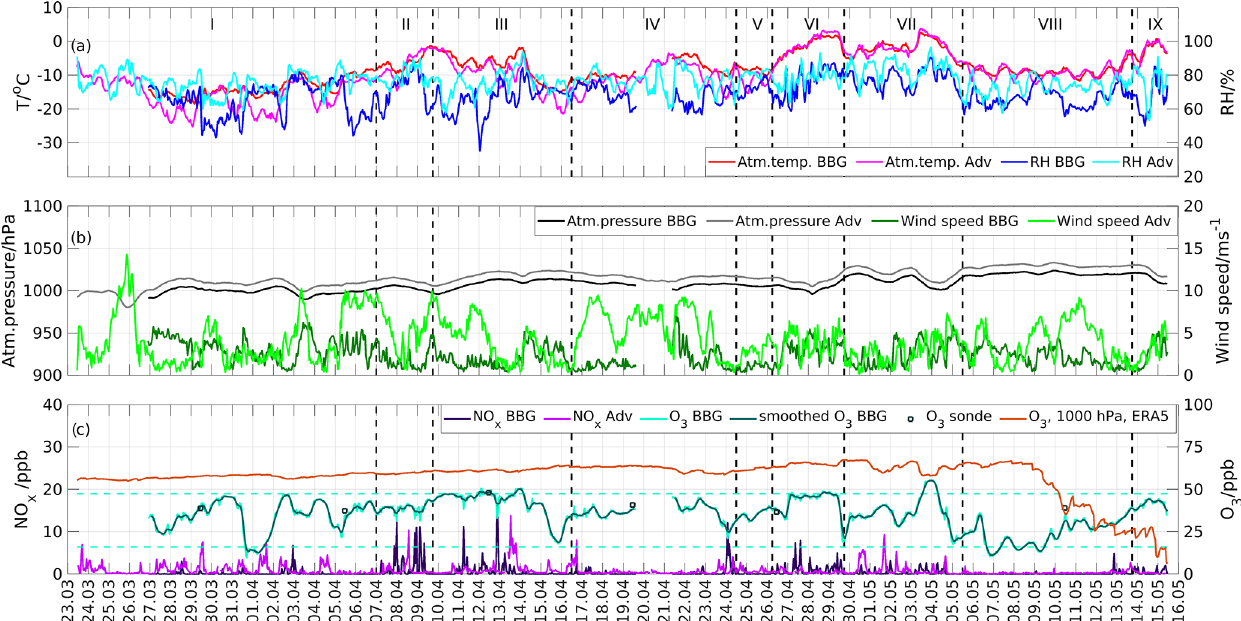
Figure 3. (a) The hourly average air temperature and relative humidity measured in Adventdalen (Adv) and Barentsburg (BBG). (b) Atmo- spheric pressure and wind speed measured in Adventdalen and Barentsburg. (c) NO x and O 3 concentrations in Adventdalen, in Barentsburg and in the ERA5 reanalysis for the nearest grid point to the coordinates of Barentsburg for the period from 23 March to 16 May 2017. The dashed black lines represent time frames of the different weather regimes. The dashed light blue line shows 5th and 95th quantiles of the O 3